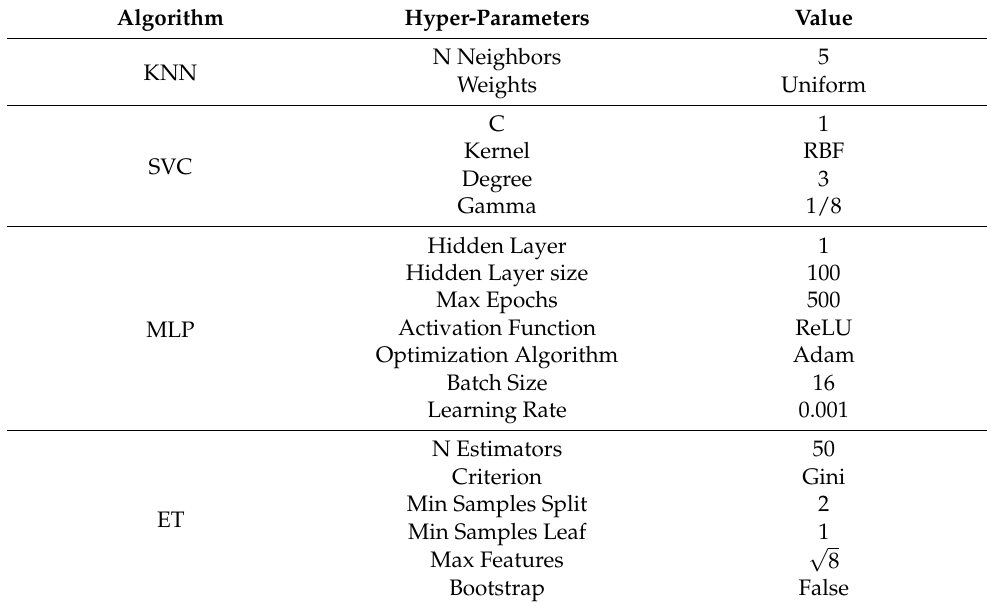
Table 5. Machine learning (ML) algorithms: Hyperparameters optimization.